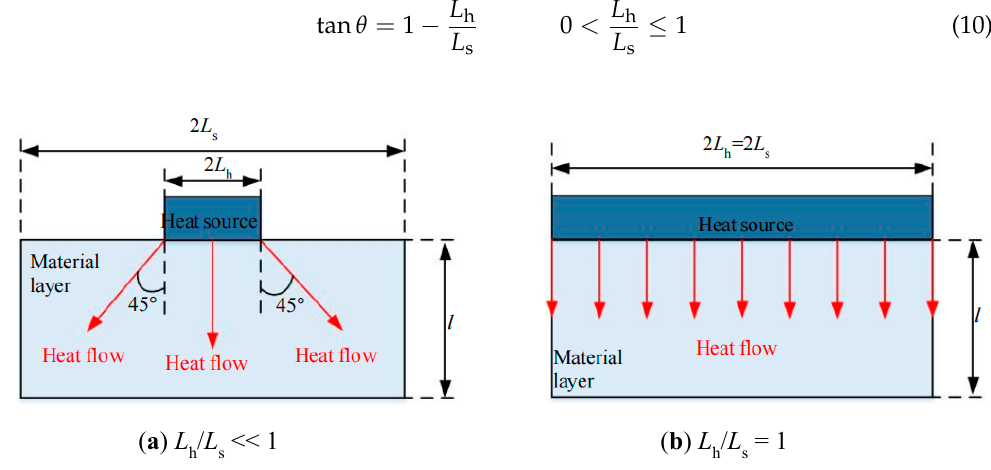
Figure 9. Effect of the lateral boundary effect on the heat spreading angle.